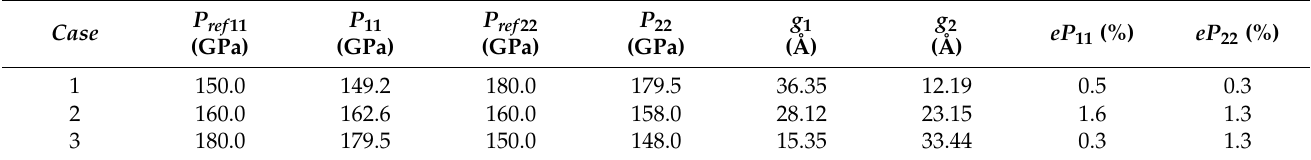
Table 1. The prescribed and resulting stiffness, ellipse radius, and error of obtained stiffness. Case